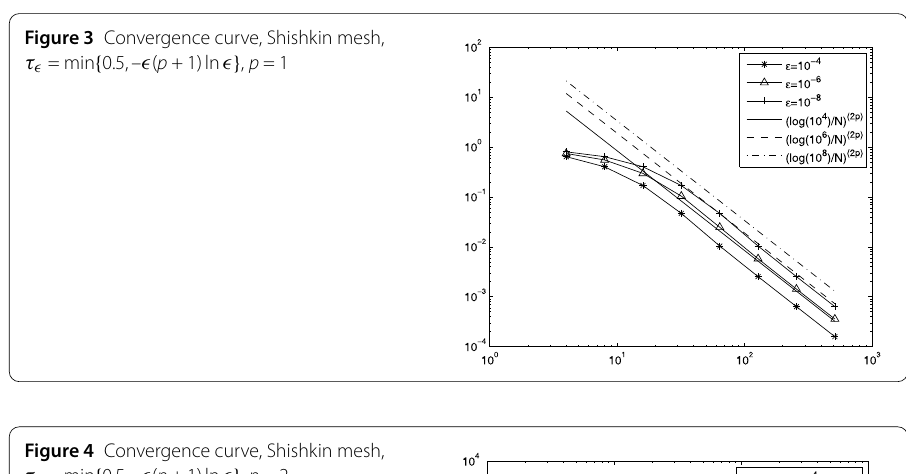
Figure 4 Convergence curve, Shishkin mesh, τ (cid:2) = min { 0.5,– (cid:2) ( p + 1)ln (cid:2) } , p = 2